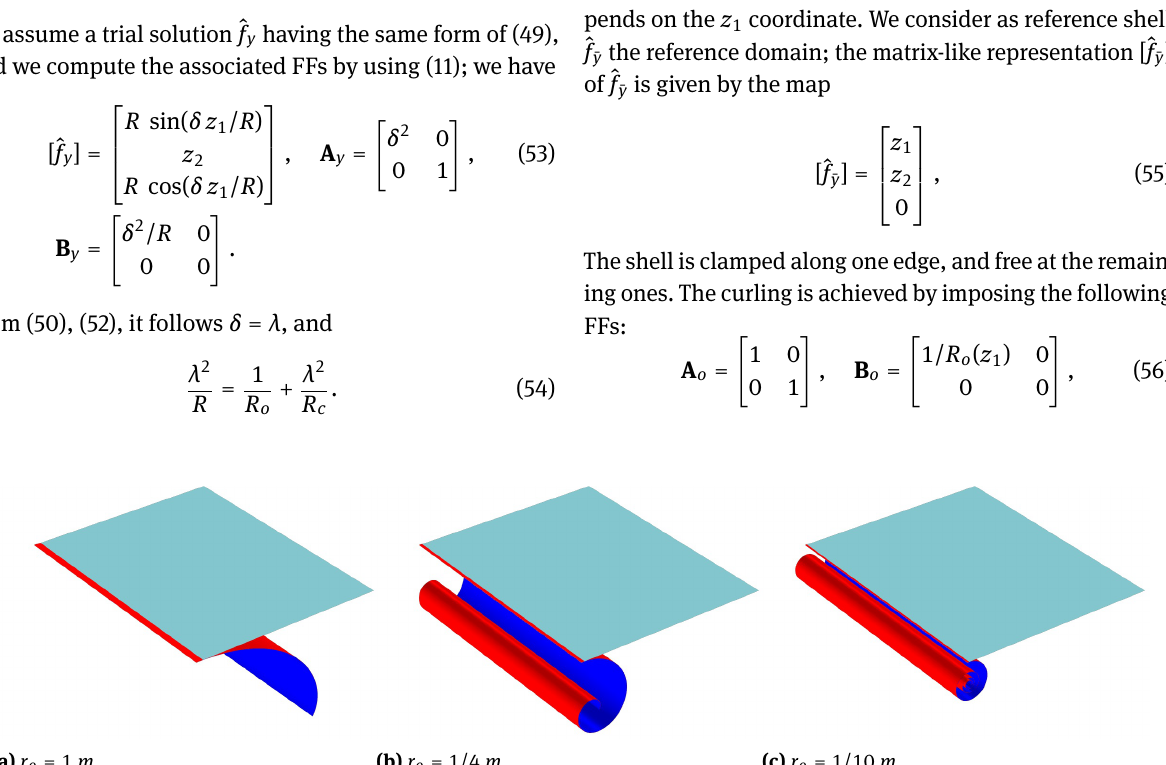
Figure 7: Effects of the non-homogeneous bending distortion for a flat shell. Each of the three figures shows the reference surface (cyan), which in this case coincides with the computational domain, and the actual surface (red up and blue at bottom) for three different values of the parameter r . Each deformed configuration is o